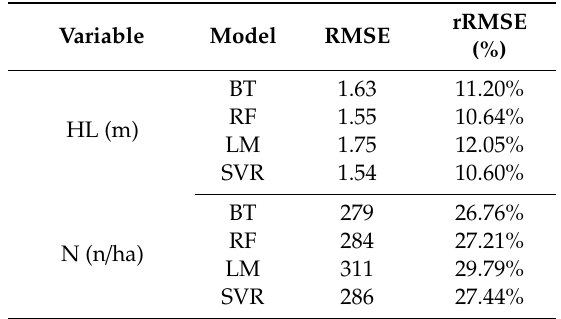
Table 5. Summary of the regression model